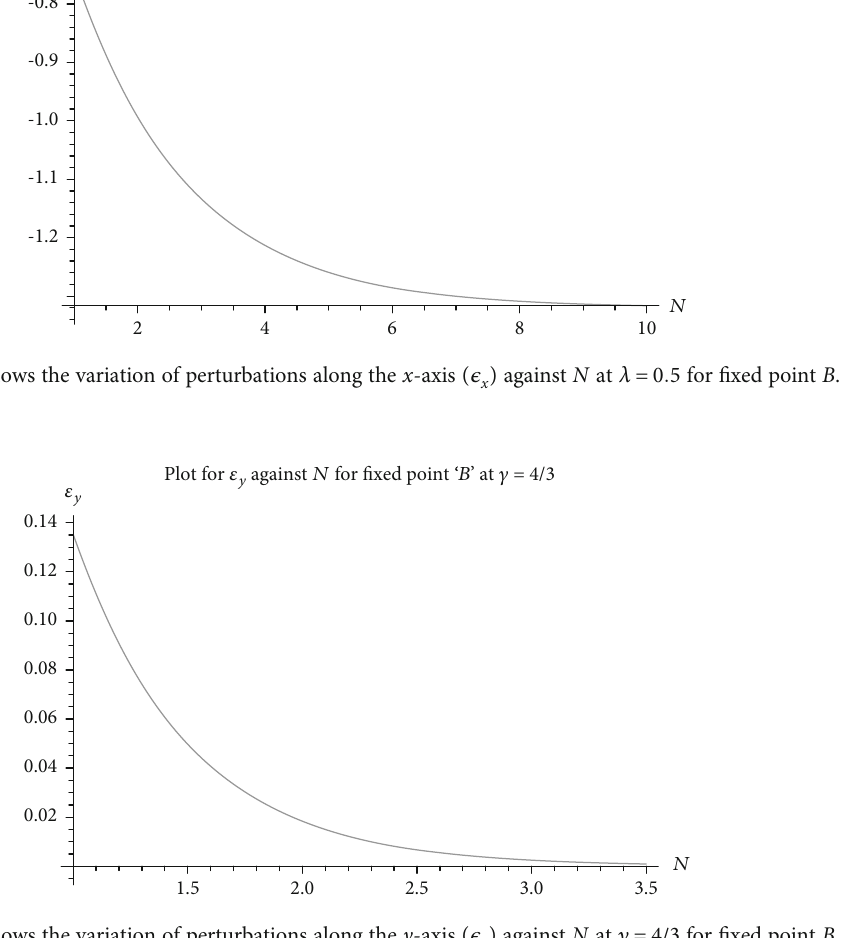
) against N at γ = 4/3 for fi xed point B y